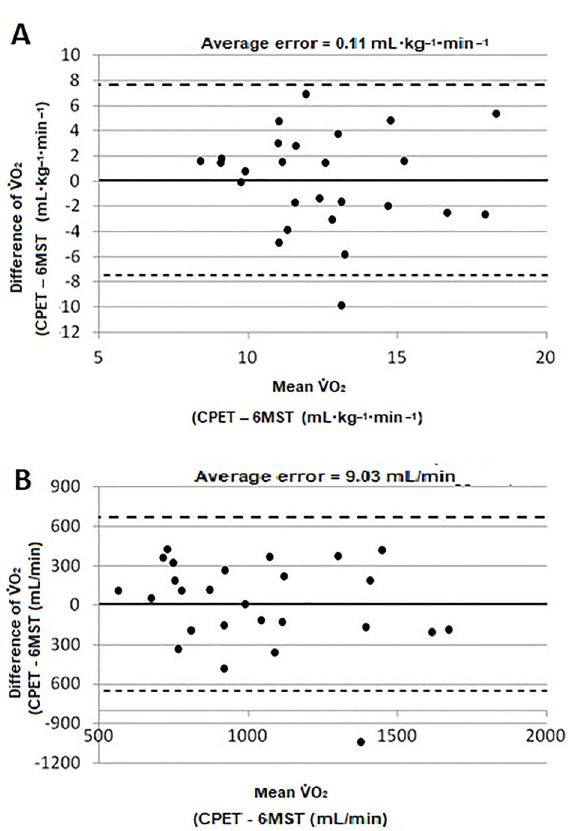
Figure 4. Bland-Altman plot for agreement analysis between six-minute step test (6MST) and cardiopulmonary exercise test (CPET) comparing the variables ( A ) V ̇ O 2 (mL (cid:3) kg – 1 (cid:3) min – 1 ) and ( B ) V ̇ O 2